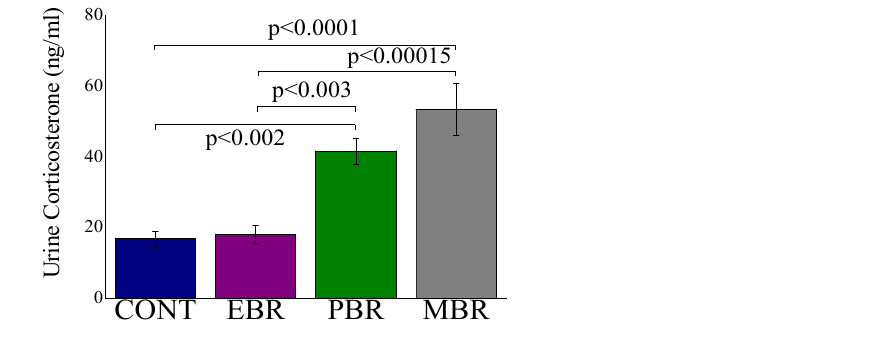
Figure 3. Urine levels of corticosterone at 1–2 h after PSS-exposure or sham-PSS: All data represent the group means ± S.E.M.